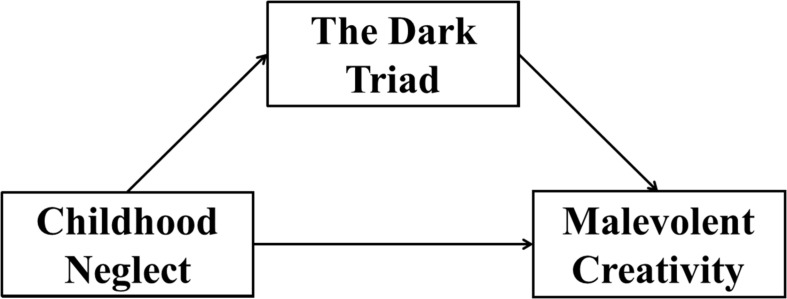
Hypothesized model.